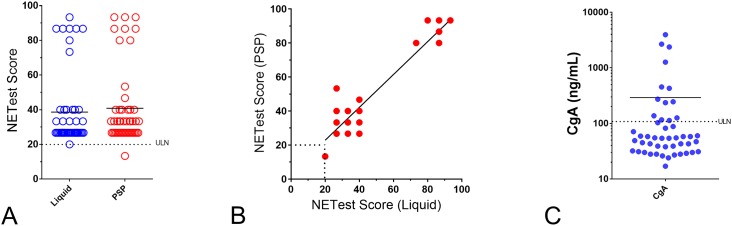
Robustness of PSP compared to CLIA-laboratory liquid sample results (Sample Set IV, n = 48).7A. Individual scores from the 48 consecutive samples using either standard CLIA approach (liquid) or on spotted plates (PSP). Scores were not significantly different. Horizontal line = mean value for each group. 7B. Individual NETest correlations between scores on standard CLIA vs. PSPs (n = 48). The correlation (Pearson r) was 0.94 (p<0.0001). 7C. Individual CgA measurements from the same 48 consecutive samples using a standard CLIA ELISA approach. Horizontal line = mean value for each group. ULN = upper limit of normal.